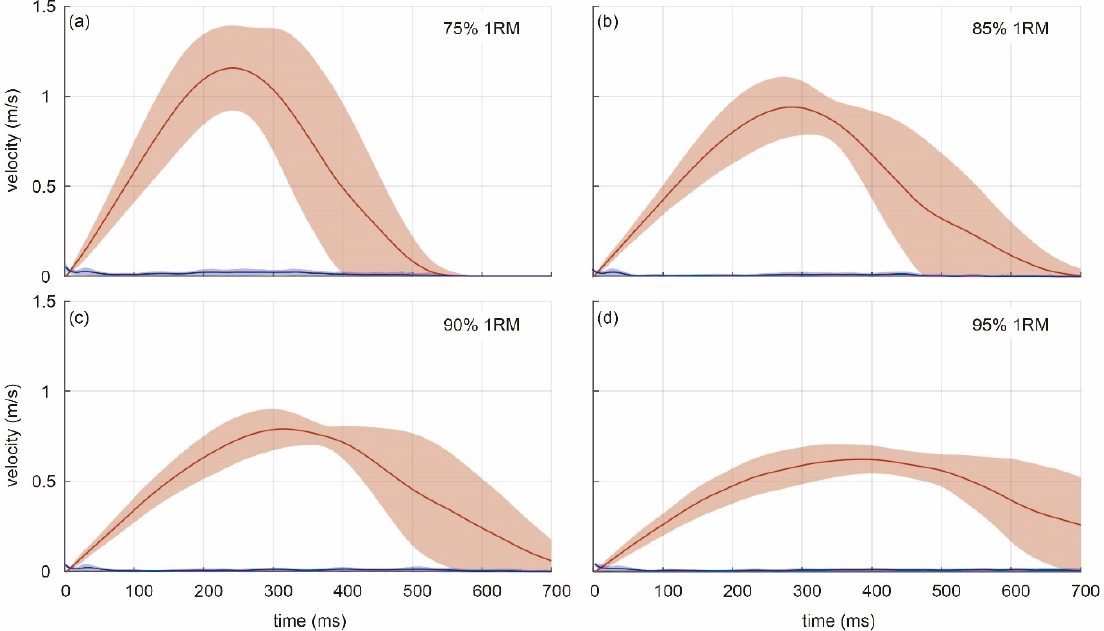
Figure 8. Velocity–time curves averaged across all subjects for the video system at ( a ) 75% 1RM, ( b ) 85% 1RM, ( c ) 80% 1RM, and ( d ) 95% 1RM. Velocity (red line) and absolute difference between LPT and video systems (blue line) shown with standard deviations (shaded area).